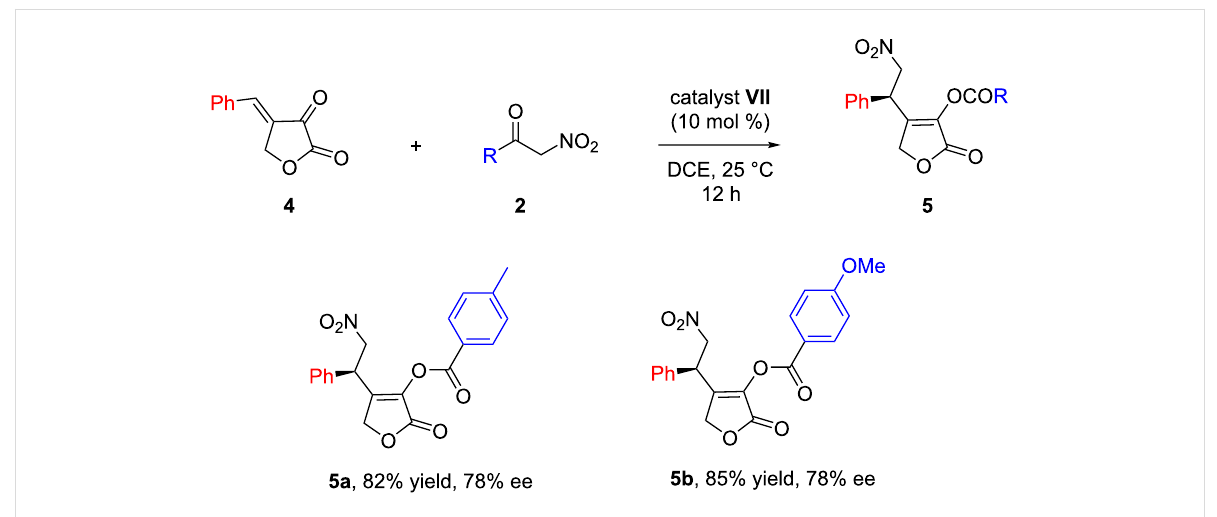
Scheme 2: Reaction of 4-benzylidenedihydrofuran-2,3-dione ( 4 ) with α -nitroketones 2b , c . Reaction conditions: furan 4 (0.1 mmol), α -nitroketone 2 (0.1 mmol), 10 mol % VII in 0.6 mL 1,2-dichloroethane were reacted at 25 °C for 12 hours. Yields correspond to isolated yields after silica gel column chromatography and ees were determined by chiral